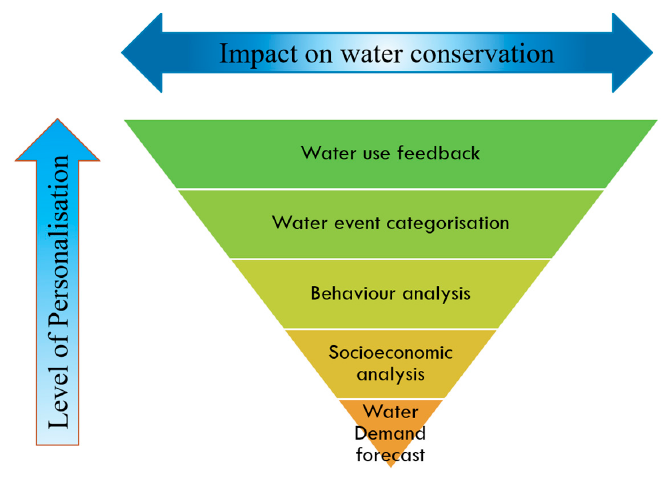
Figure 4. Relationship between personalisation and water conservation.